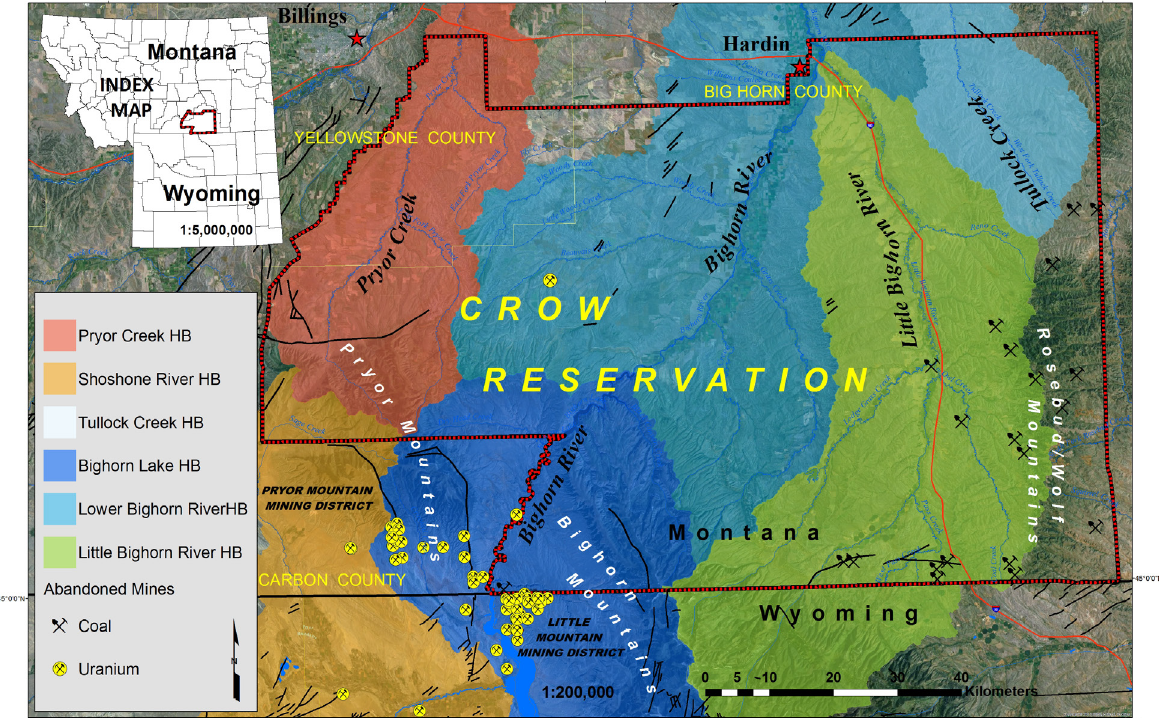
Figure 1. Study area, showing the Crow Reservation (outlined by the red and black border). Hydrologic basins (HB) for the major drainages, mountain ranges and the location of the two abandoned uranium mining districts southwest of the reservation are shown. The Bighorn/Yellowstone County line is delineated in